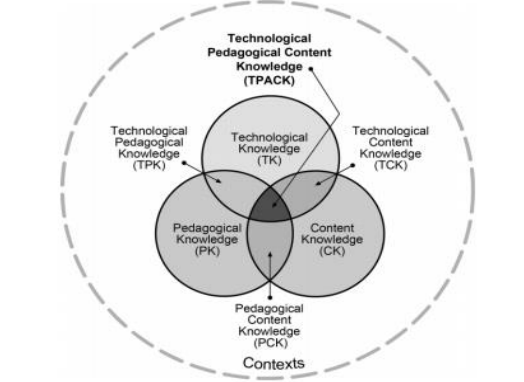
Fig. 1. TPACK Model